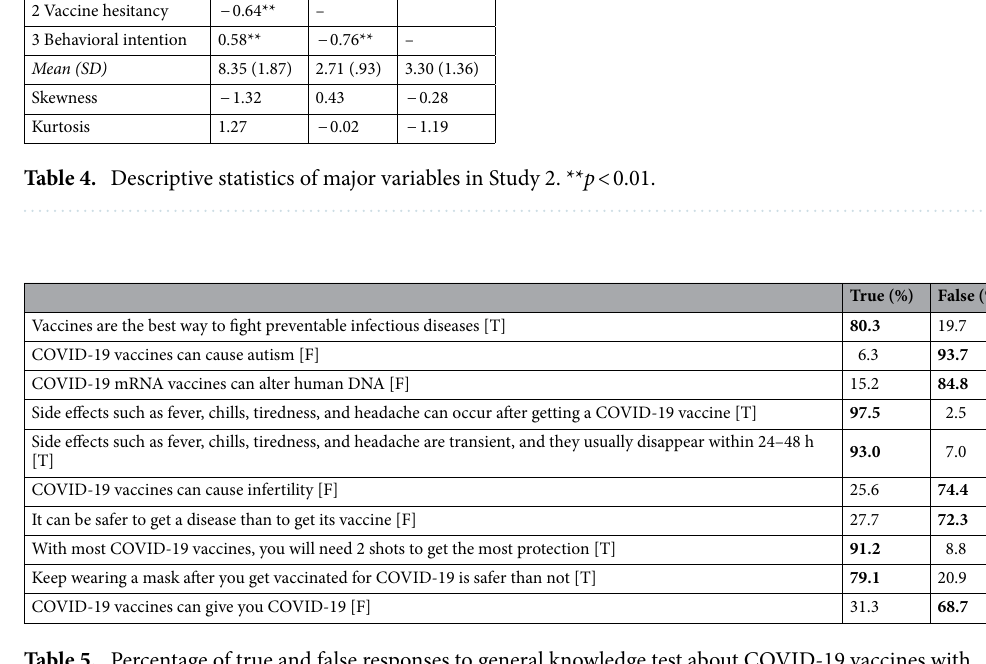
Table 5. Percentage of true and false responses to general knowledge test about COVID-19 vaccines with correct answers in bold font.